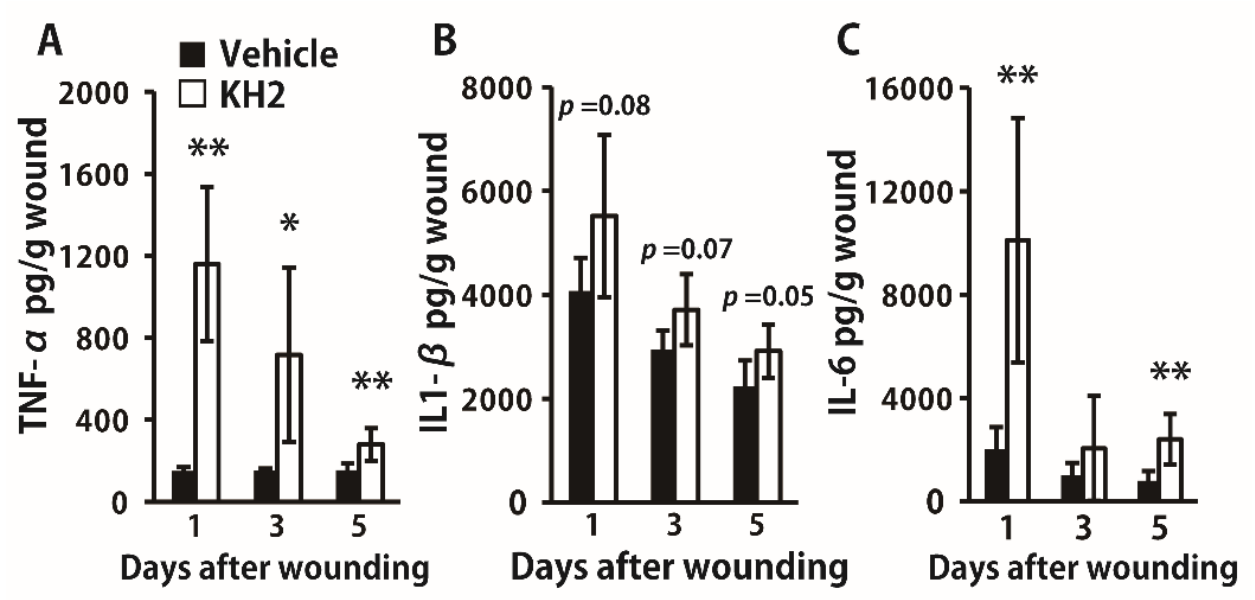
Figure 2. Effect of heat-killed KH2 administration on the production of TNF- α , IL-1 β , and IL-6. ( A ) Production of TNF- α in the homogenates of wound tissues was measured on days 1, 3, and 5 after wound creation ( n = 5–6 mice). ( B ) Production of IL-1 β in the homogenates of wound tissues was measured on days 1, 3, and 5 after wound creation ( n = 5–6 mice). ( C ) Production of IL-6 in the homogenates of wound tissues was measured on days 1, 3, and 5 after wound creation ( n = 5–6 mice). Each column represents the mean ± standard deviation. The results are representative of at least two independent experiments. * p < 0.05, ** p < 0.01.